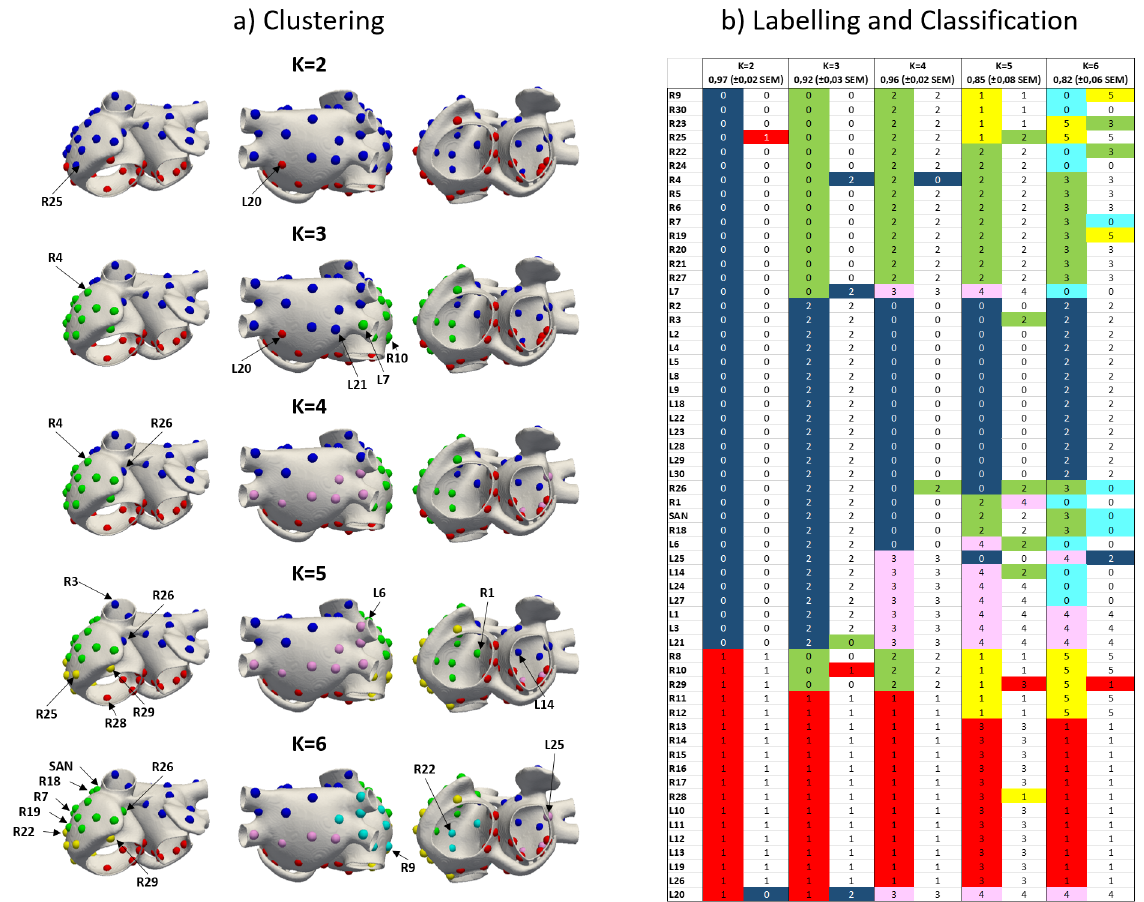
Fig 8. Clustering and classification of BSPiMs. a) Clusteringof the 57 patterns of BSPiM (30 from RA and 27 from LA) plus the SAN using the K-means algorithmon the torso surface nodes where K is the numberof pre-defined ECs. For each K, all the foci belongingto the same EC have the same colour. b) For each K, left column shows the colour and numberof each EC resultingfrom the clusteringstep (for example blue-k2-0 refers to blue EC, equivalentto class 0, when k = 2) whileright column shows the classification results identifyingthe ectopic site that is not well classifiedwith the colour of the correct group, to which it really belongs.